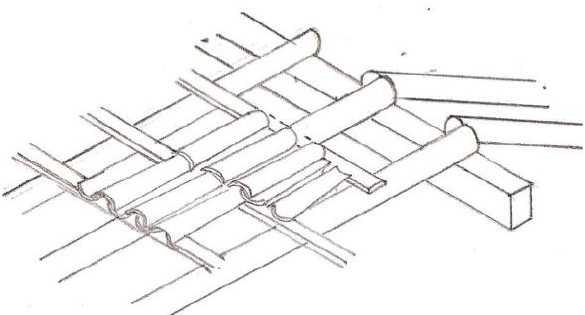
Figure 8. Sketch of constructive system typology. (Source: own